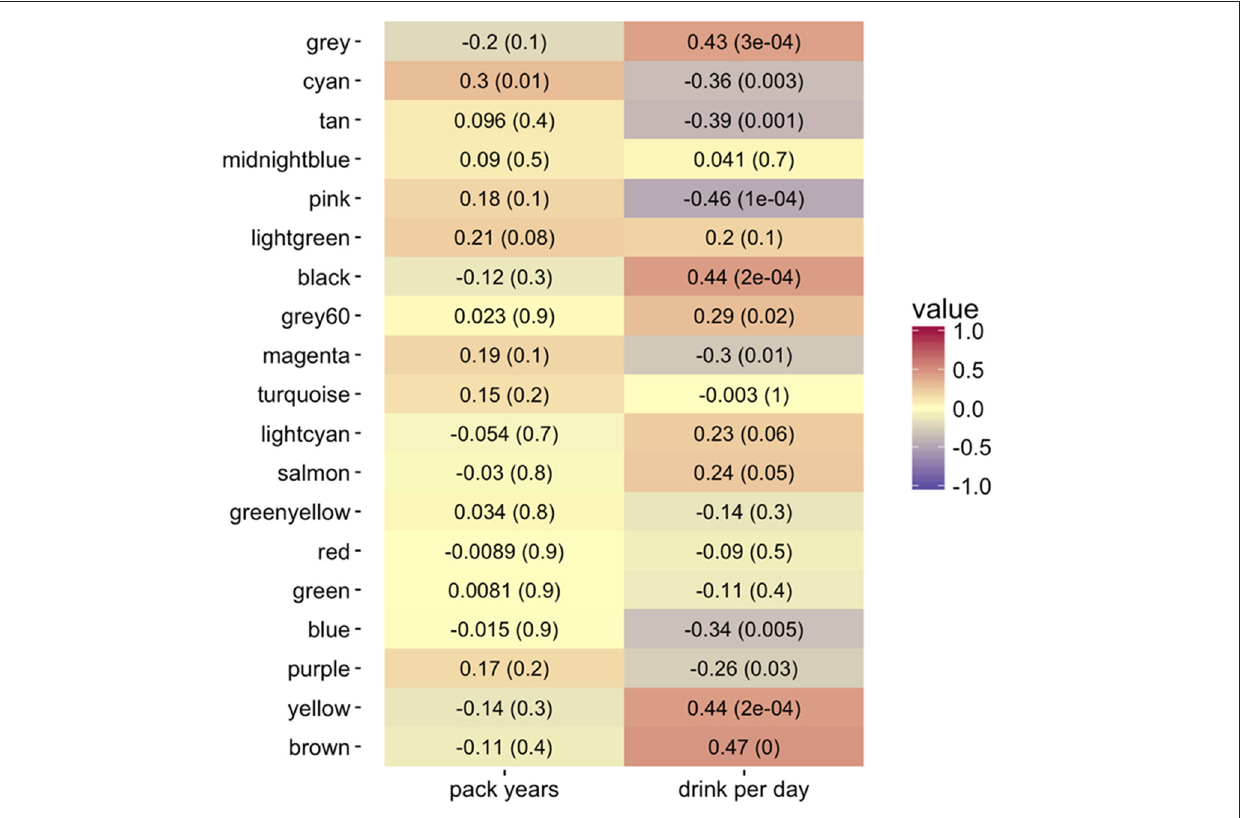
Table 2 ) that were both hubs (kME > 0.8) and